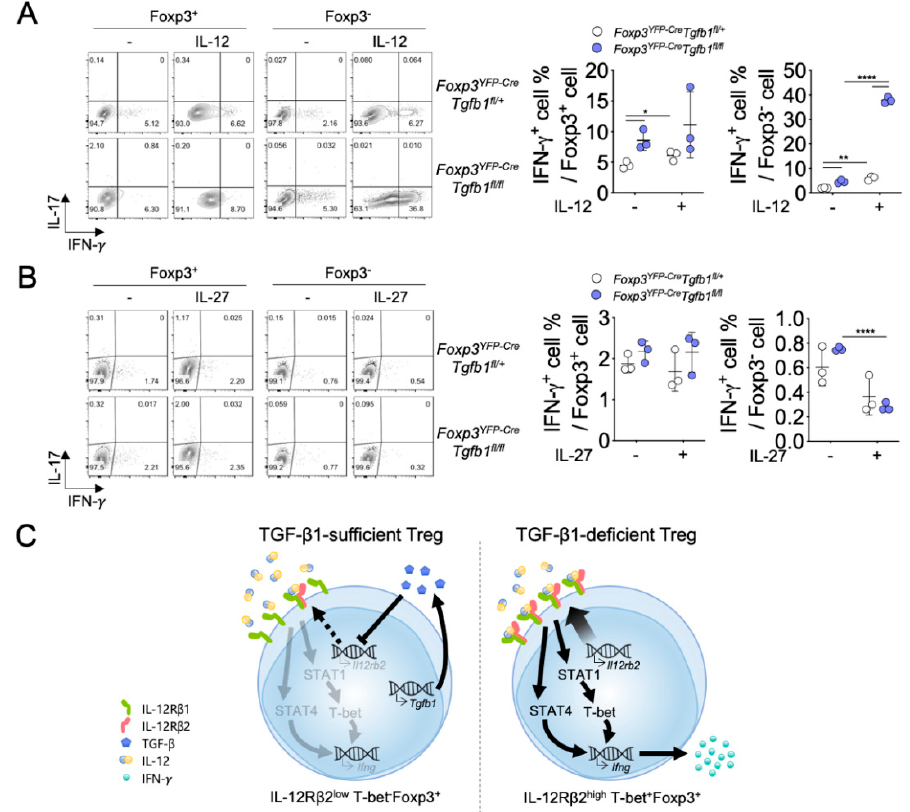
Figure 5. Ablation of TGF- β 1 induces excessive IFN- γ production of Treg cells after IL-12 stimulation. ( A ) Sorted Treg cells from Foxp3 YFP-Cre Tgfb1 fl /+ and Foxp3 YFP-Cre Tgfb1 fl / fl mice were stimulated with anti-CD3 ε with ( + group) or without IL-12 ( − group). Representative contour plots and quantification of IFN- γ - and IL-17A-expressing cells. ( B ) Sorted Treg cells from Foxp3 YFP-Cre Tgfb1 fl /+ and Foxp3 YFP-Cre Tgfb1 fl / fl mice were stimulated with anti-CD3 ε with ( + group) or without IL-27 ( − group). Representative contour plots and quantification of IFN- γ - and IL-17A-expressing cells. Data are representative of four ( A , B ) independent experiments, and values are expressed as the mean ± SD ( A , B ). * p ≤ 0.05, ** p ≤ 0.01, and **** p ≤ 0.0001 compared to TGF- β 1-sufficient Treg cells based on Student’s t -test. ( C ) Schematic model of the proposed mechanism.